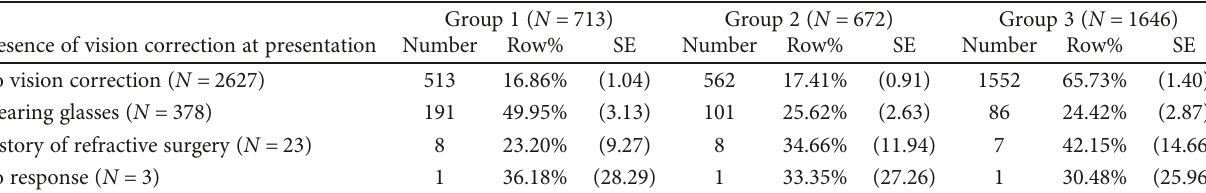
Table 4: The proportion of each group according to the vision correction status at presentation.